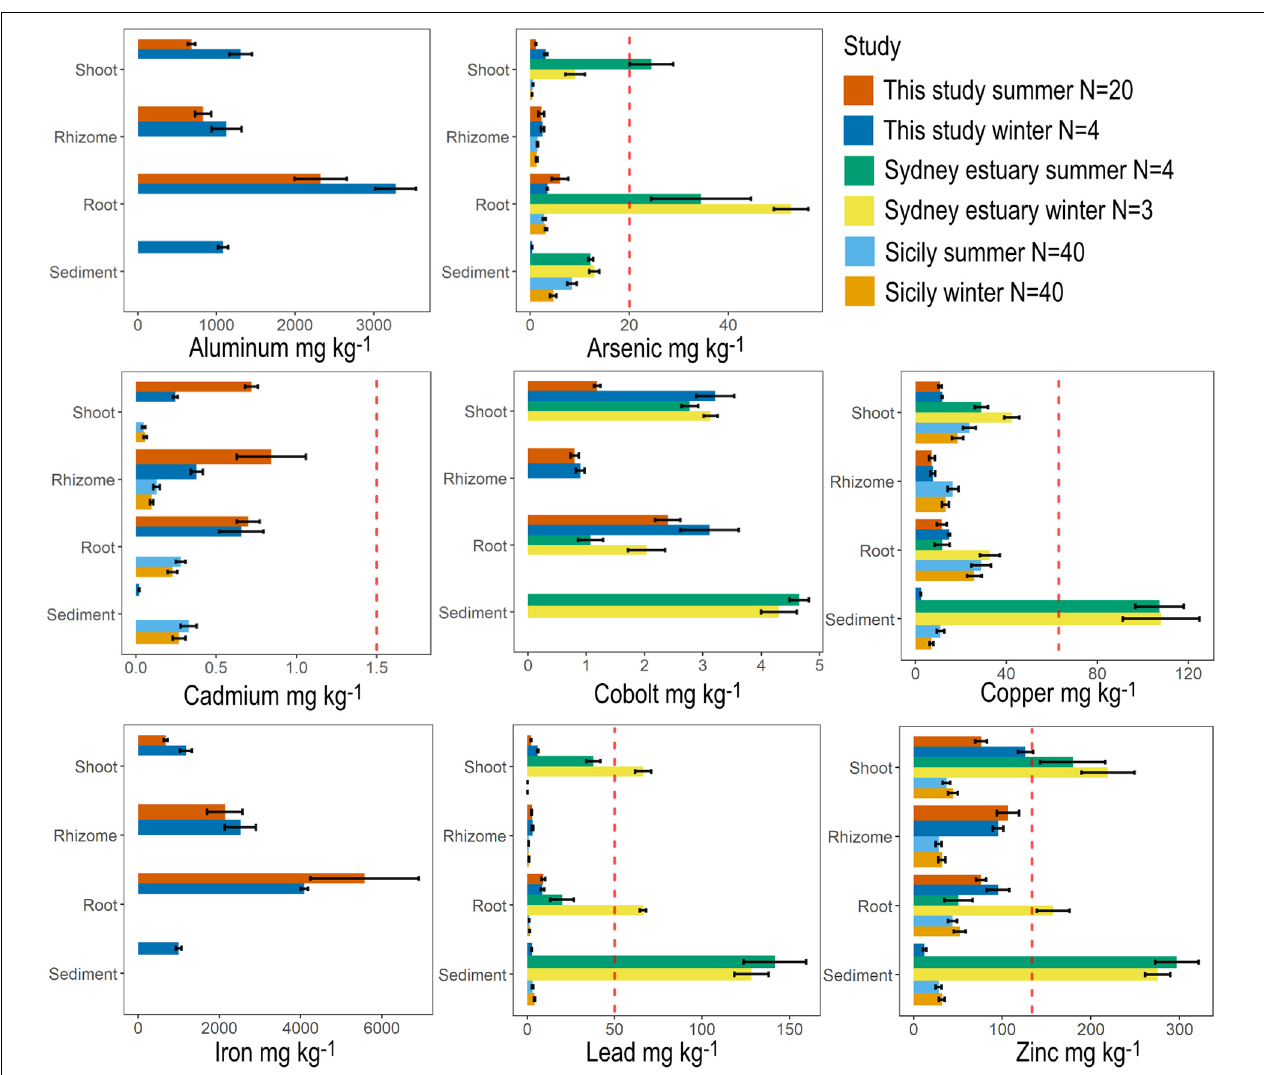
FIGURE 5 | Metal concentrations in seagrass tissue (shoot, rhizome and roots) across all sites compared with mean values recorded from the literature for Halophila species. Seagrass tissue at site N1 was also analyzed for metals during June (winter). The dashed red line indicates the default value guideline (the concentrations below which there is a low risk of unacceptable effects occurring) for toxicants in sediment according to the Australian and New Zealand Guidelines for Fresh and marine water. Values for the Sydney estuary were taken from Birch et al. (2018a) and values from Sicily were taken from Bonanno and Raccuia